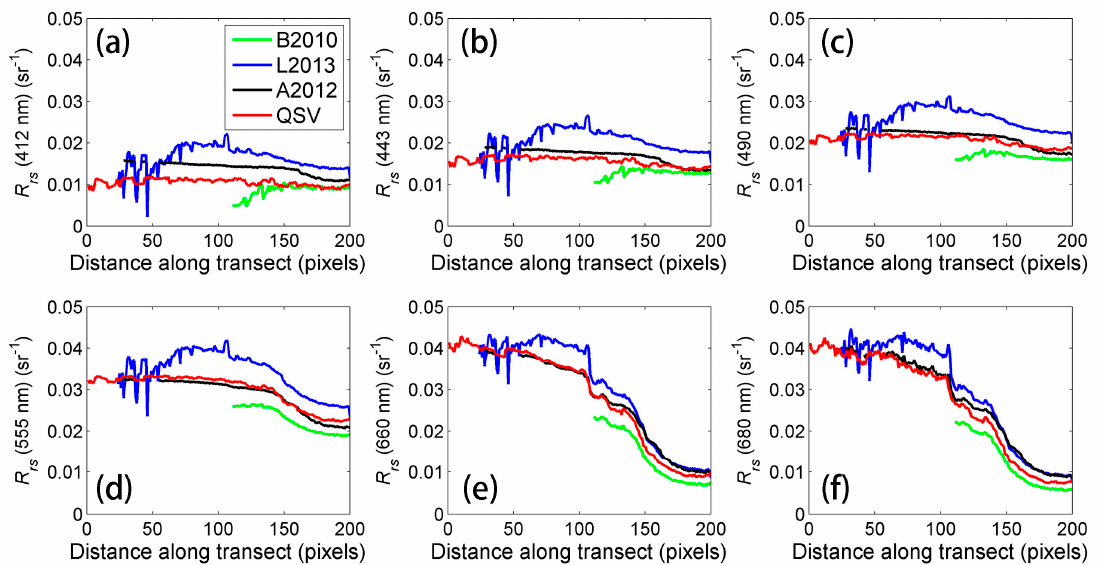
Figure 5. Comparison of the R rs values extracted from the pixels along the red arrow in Figure 4a at wavelengths of ( a ) 412, ( b ) 443, ( c ) 490, ( d ) 555, ( e ) 660, and ( f ) 680 nm. A distance of 0 in the x-axis indicates the location closest to the coast.